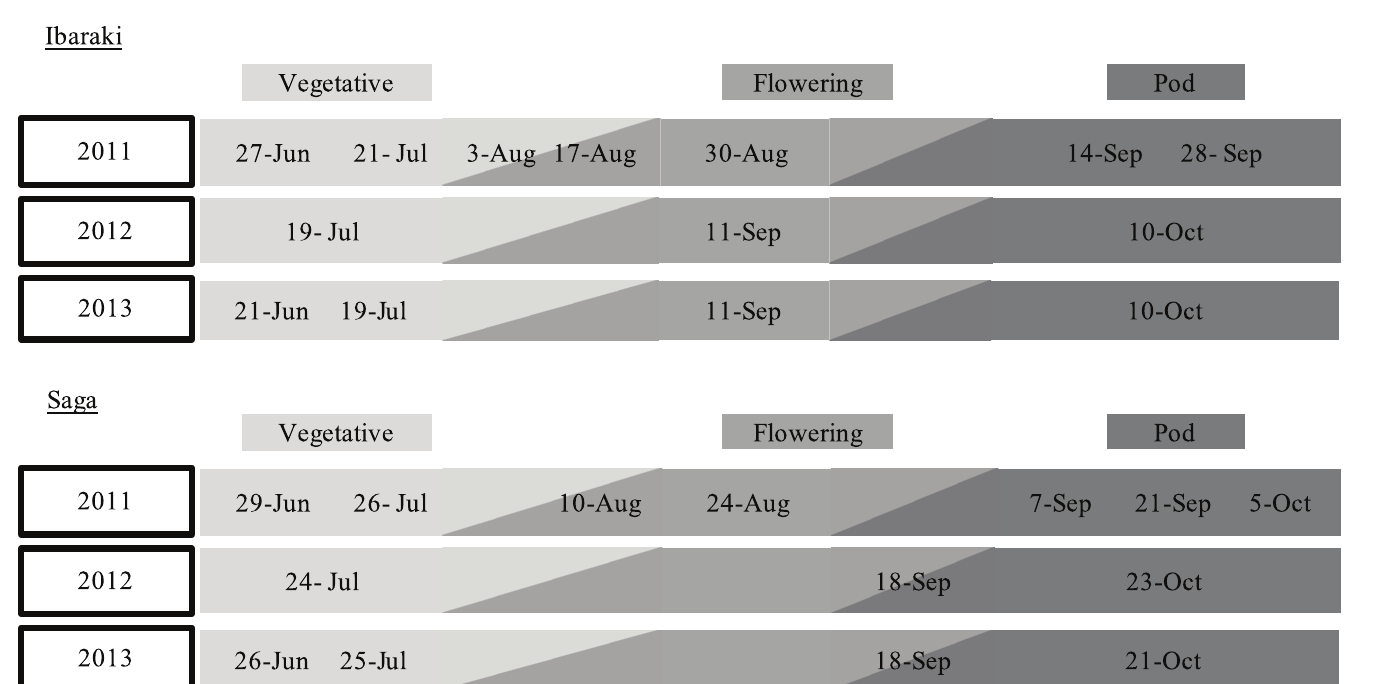
Fig 1. The growth stages of wild soybean at each observation time at each site during each year. Growth stages were defined as; Vegetative (VE — Vn), Flowering (R1 – R2), and Pod/seed development (R3 – R8) as described by Pedersen [41]. The date associated with the bars denotes the observation date at each site. Observation date including two different colors ( e . g ., 10-Aug., 2011) indicates that the growth stage of wild soybean varied among plants of the same population at that